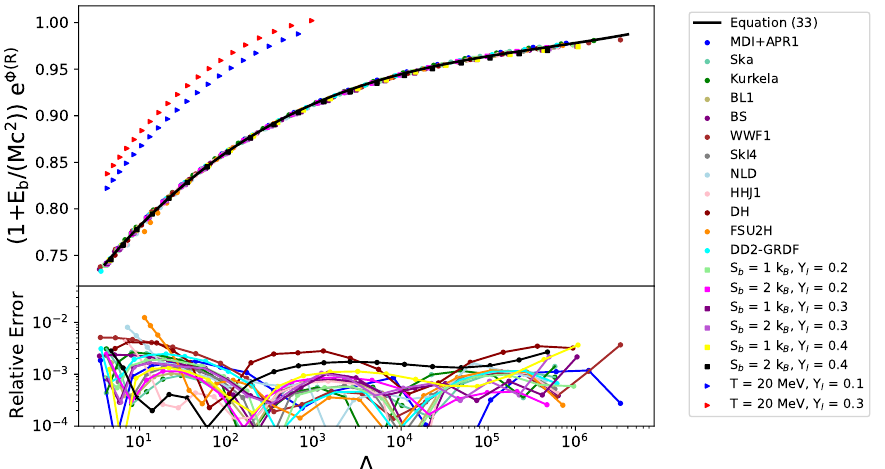
Figure 8. Top panel: Universal relation connecting the dimensionless tidal deformability, the star’s binding energy and the compactness. The universality extends to finite isentropic EOSs as well. The circular and the rectangular points correspond to cold and isentropic EOSs, respectively. The triangular points correspond to isothermal EOSs. The solid line stands for the fit of Equation (33), which was performed for cold and hot EOSs. Bottom panel: Relative error for the fit of Equation (33). Table 4. Fit parameters for Equation (33). The R 2 index is also included for completeness.